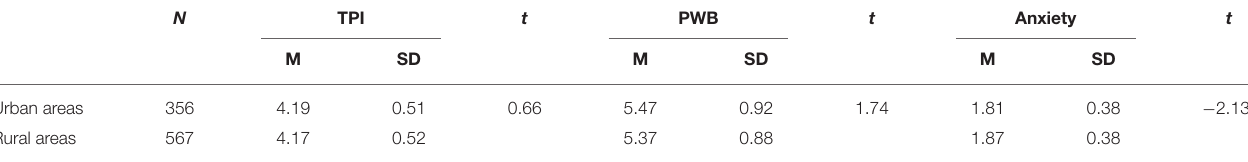
TABLE 6 | Regional differences in means of teacher professional identity, psychological wellbeing and